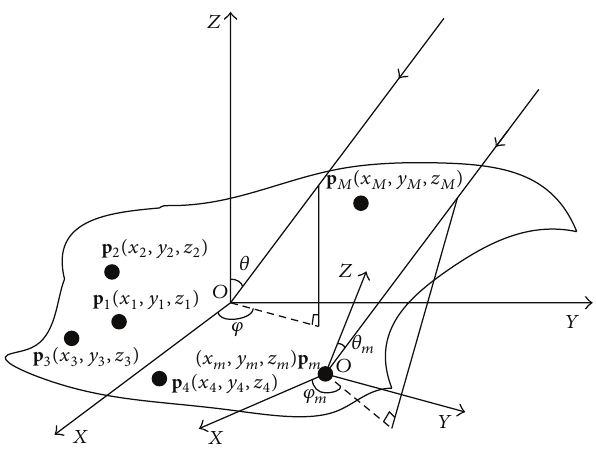
Figure 1: The structure of the conformal